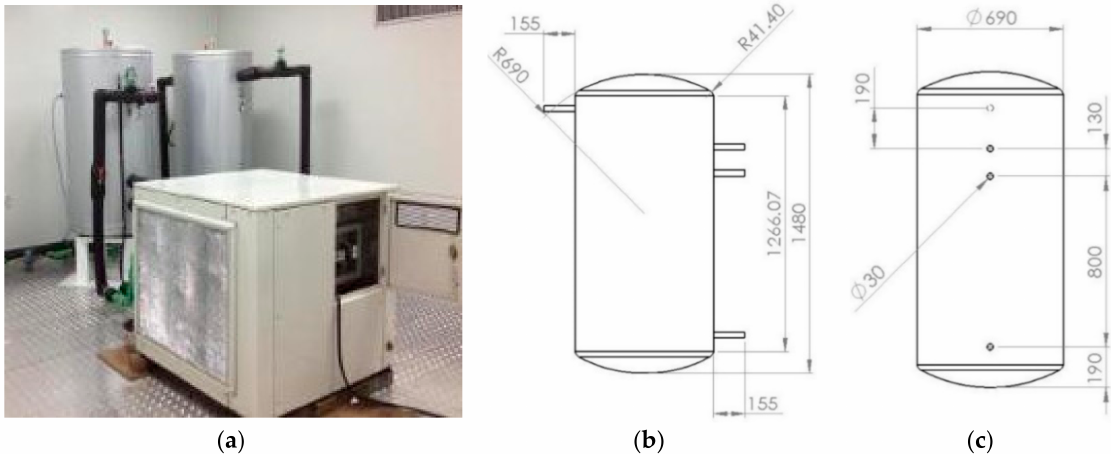
Figure 1. The geometry of the storage tank: ( a ) The experimental facilities for testing the heat pump performance; ( b ) Front view of the storage tank (unit: mm); ( c ) Side view of of the storage tank (unit: mm).